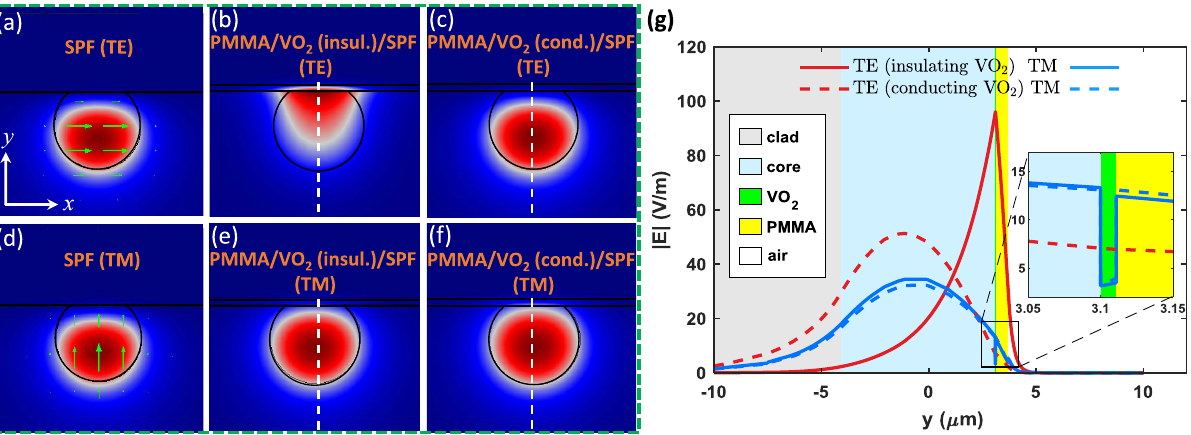
Figure 2: The electric field profiles of (a) TE mode and (d) TM mode of the bare SPF. The electric field profile of (b) TE mode and (f) TM mode in the PSMS-SPF with PMMA/graphene/VO /graphene coatings where VO is in the insulating phase. The electric field profile of (c) TE mode 2 2 is in the conductingphase. The green arrows in (a) and(d) illustrate the magnitudeanddirection and (e) TM modeof the PSMS-SPF where VO 2 of the electric field. (g) The electric field amplitude of TE and TM modes along the central cut-lines (white dashed lines) of (b), (c), (e) and (f).